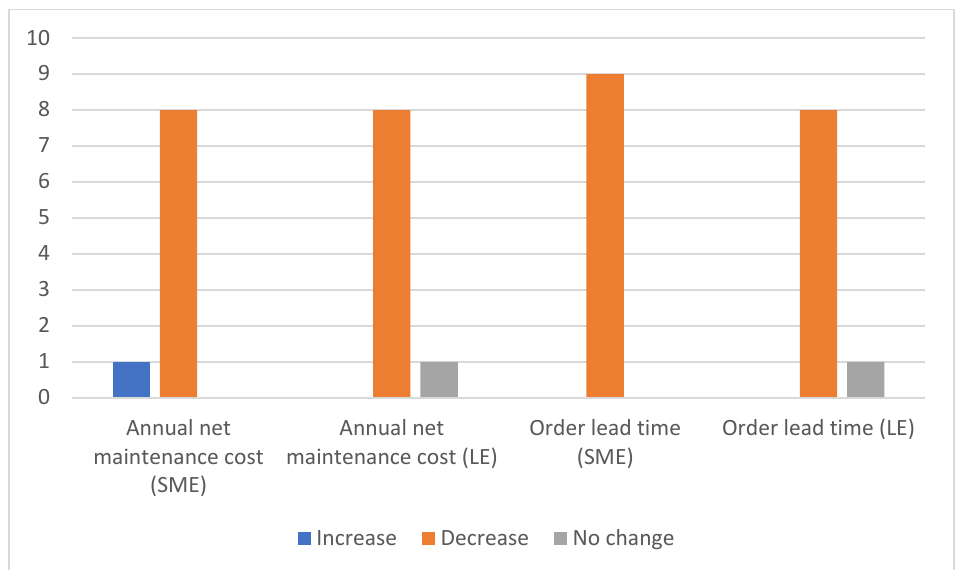
Figure 2. Participants’ responses on impact of IoT on inventory accuracy, annual net maintenance cost, and order lead time for SMEs and LEs.